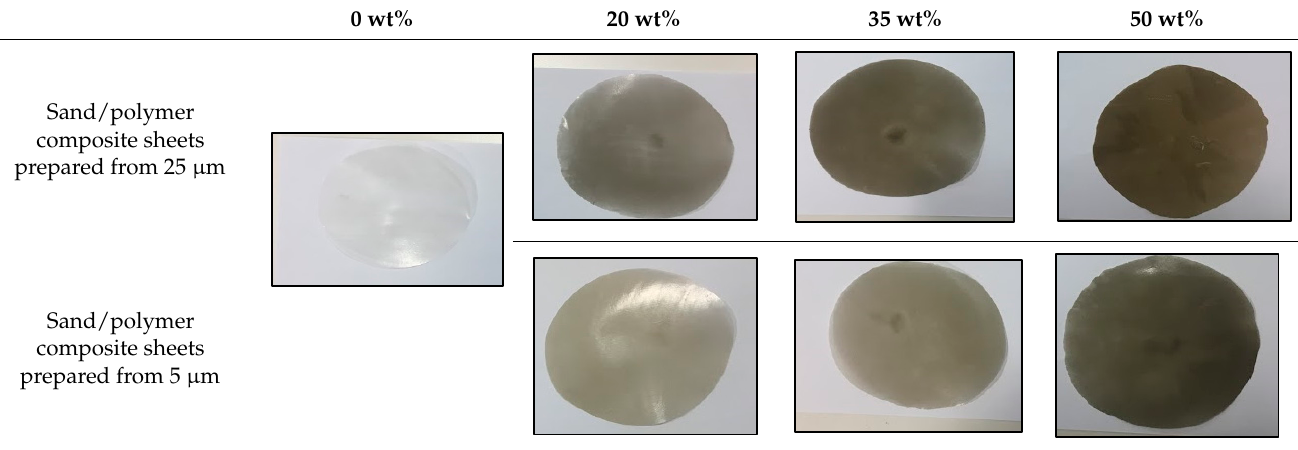
Table 3. Prepared composite sheets with varying filler wt%.